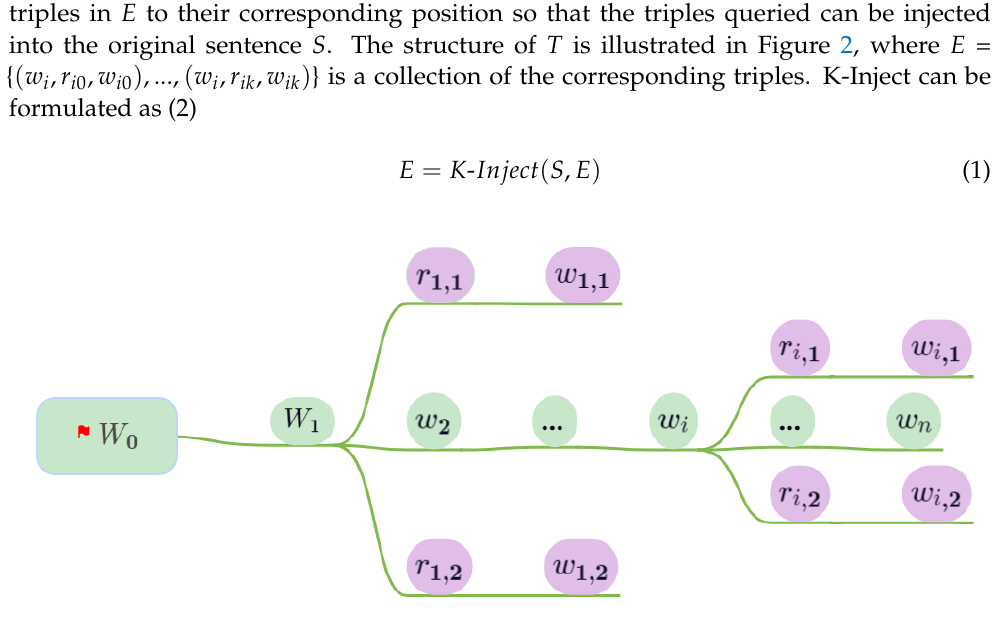
Figure 2. Structure of the sentence